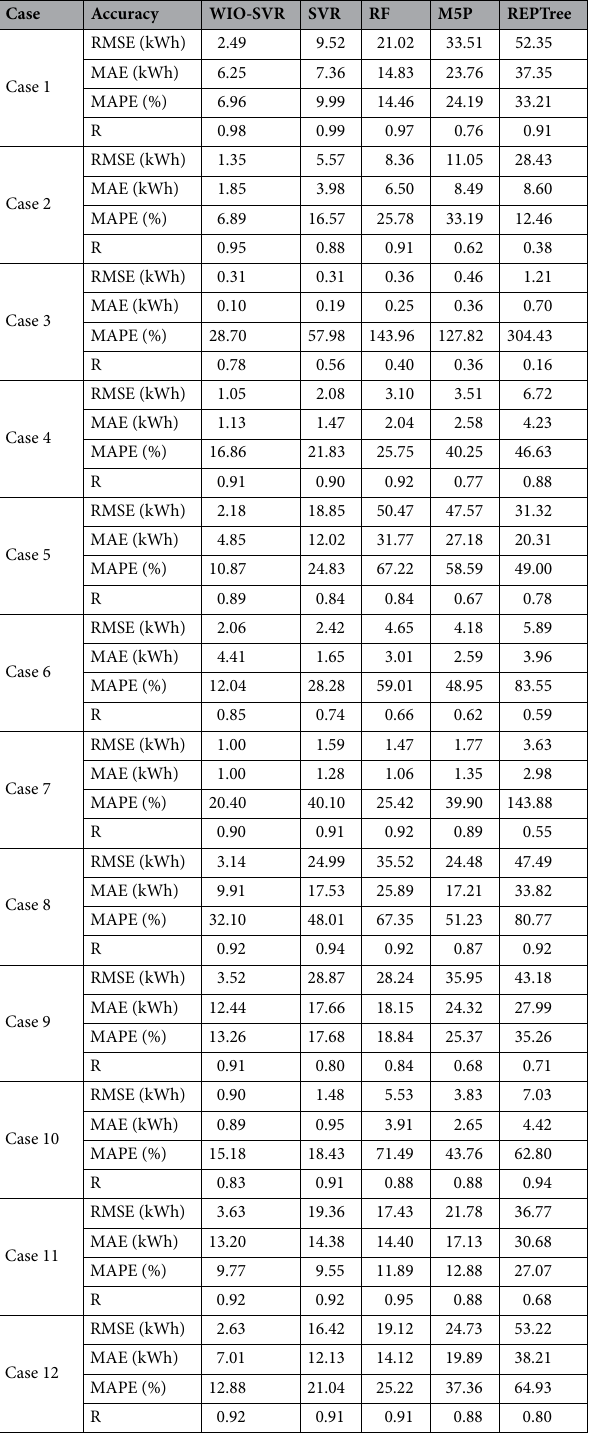
Table 5. Performance comparison among prediction